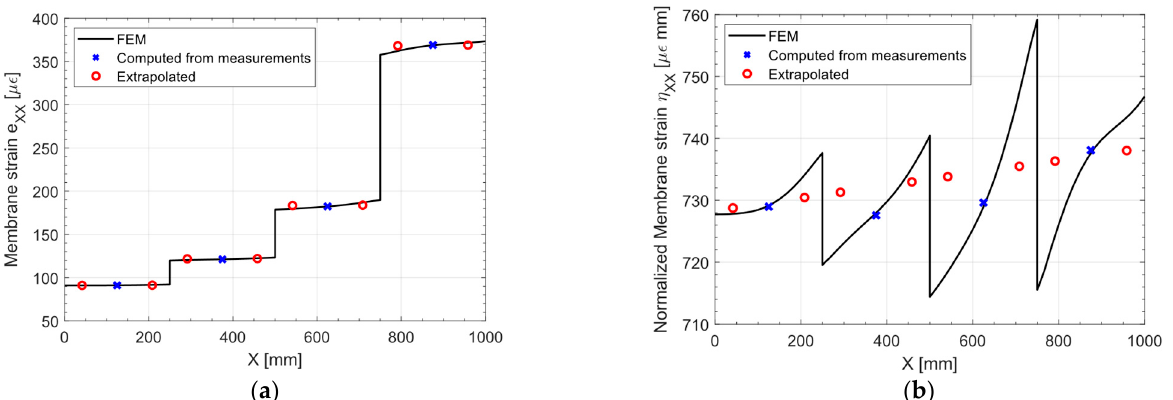
Figure 7 . Traction: ( a ) membrane strain 𝑒 (cid:3025)(cid:3025) and ( b ) normalized membrane strain 𝜂 (cid:3025)(cid:3025) , slice at Y = Figure 7. Traction: ( a ) membrane strain e XX and ( b ) normalized membrane strain η XX , slice at 250 mm. Y = 250